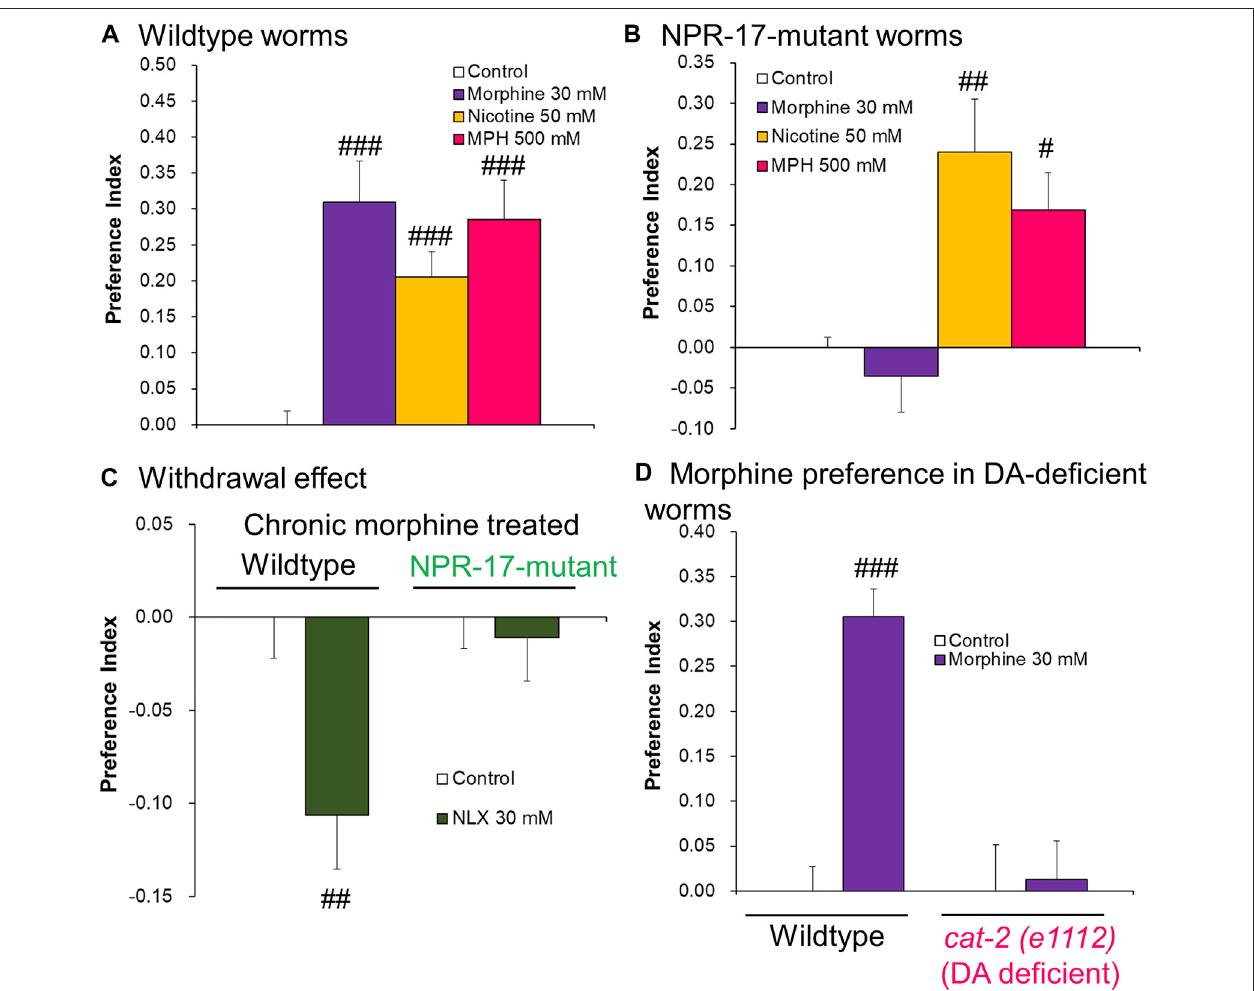
(cid:1) 18.42, p < 0.0001.(control, n (cid:1) 14;morphine, n (cid:1) 6;nicotine, n (cid:1) 8;MPH, n (cid:1) 6) (B) Preference 3,20 IndexinNPR-17-mutantwormsafter1